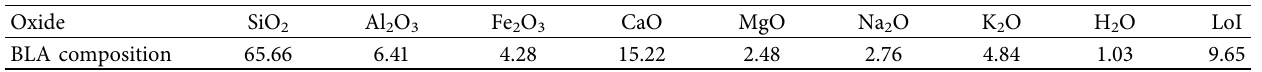
Table 2: Chemical composition of BLA.